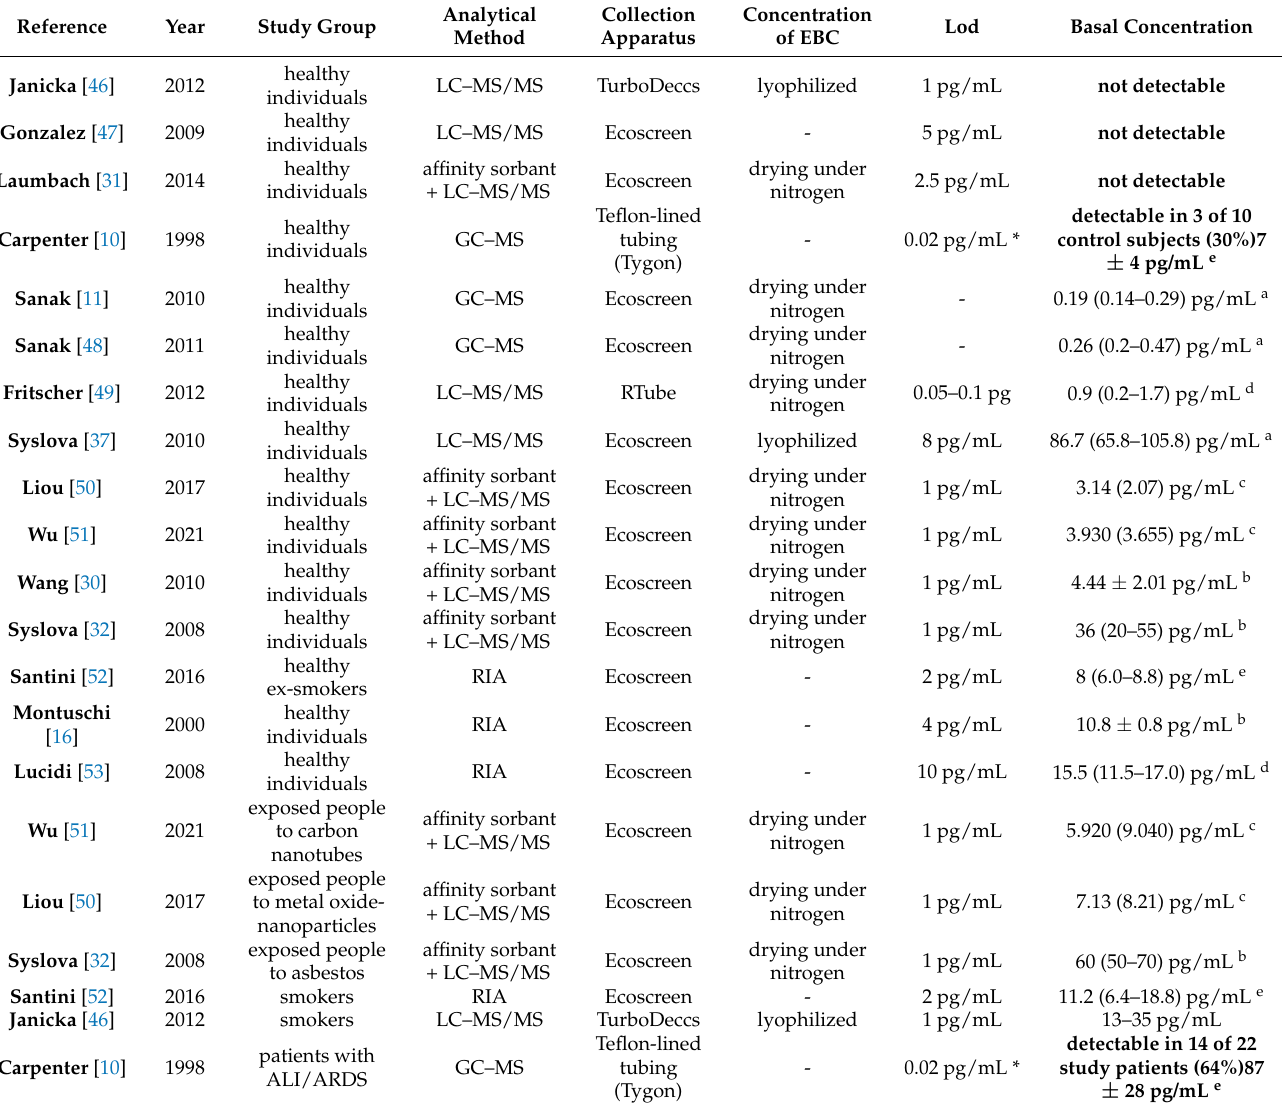
Table 3. Reported concentrations of 8-isoprostane in EBC in literature by validated RIA, GC–MS, and LC–MS